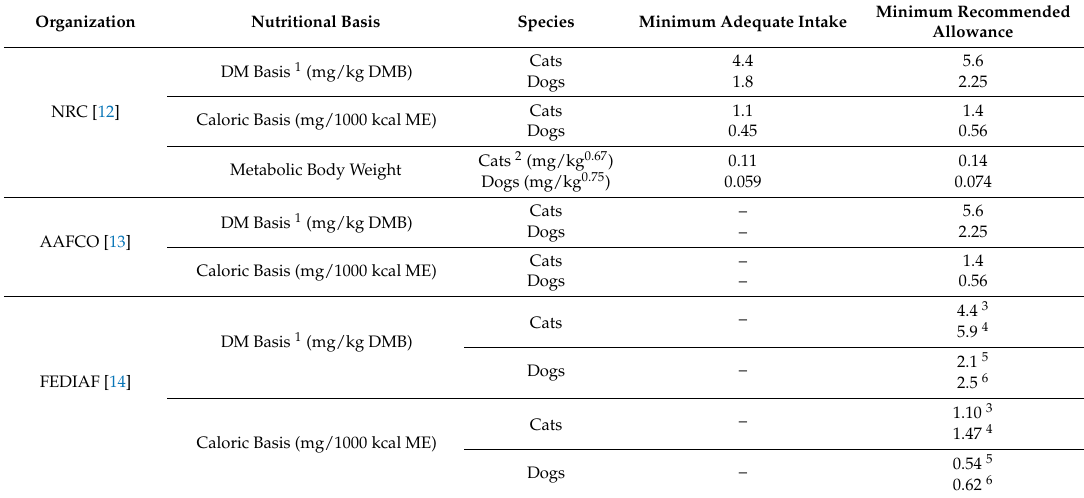
Table 1. Recommendations for dietary thiamine set by the NRC (2006), AAFCO (2017), and FEDIAF (2017) for adult dogs and